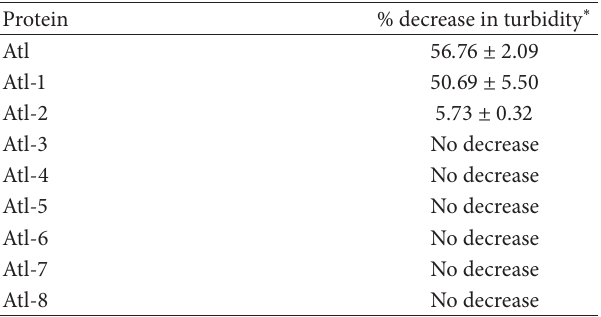
Table 2: Lytic activity of purified recombinant His-tagged Atl proteins.